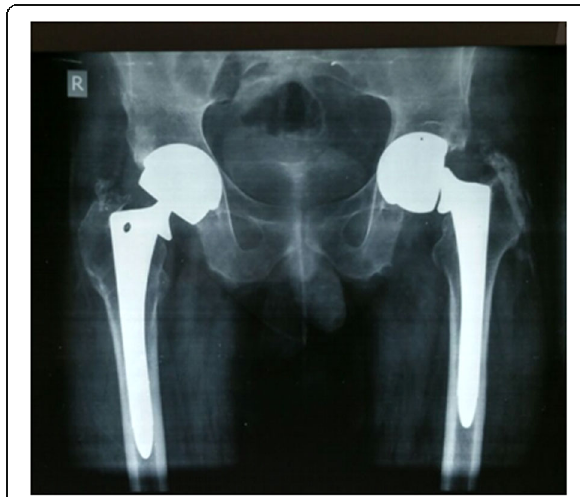
Fig. 1 A plain radiograph at the time of presentation, showing bilateral large uncemented metal-on-metal total hip arthroplasty, with trunnion fracture on the left